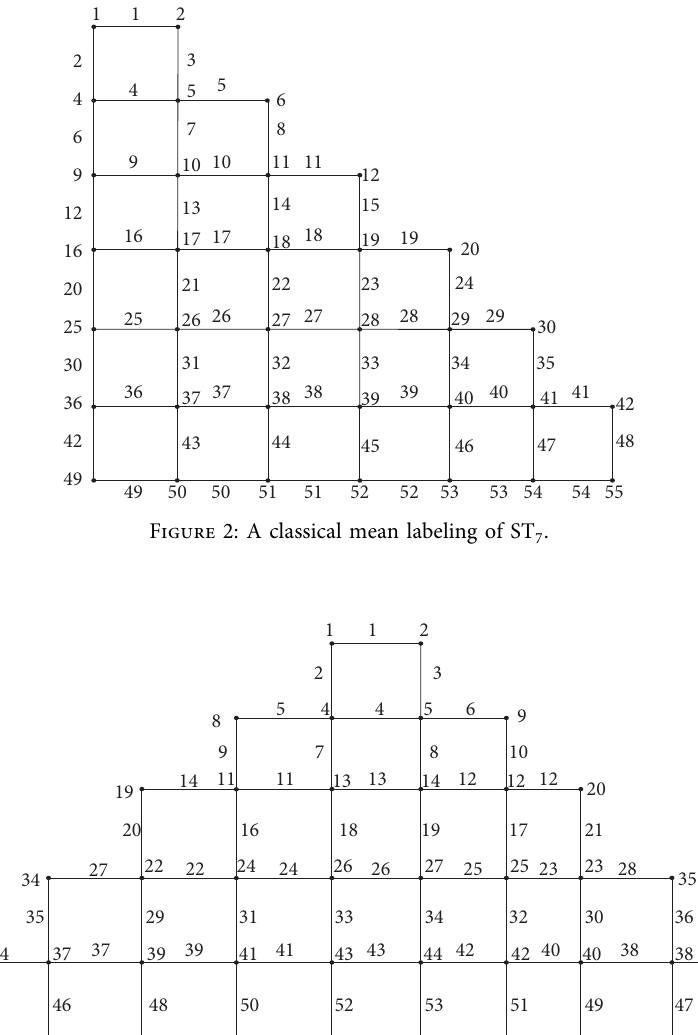
Figure 3: A classical mean labeling of 2ST